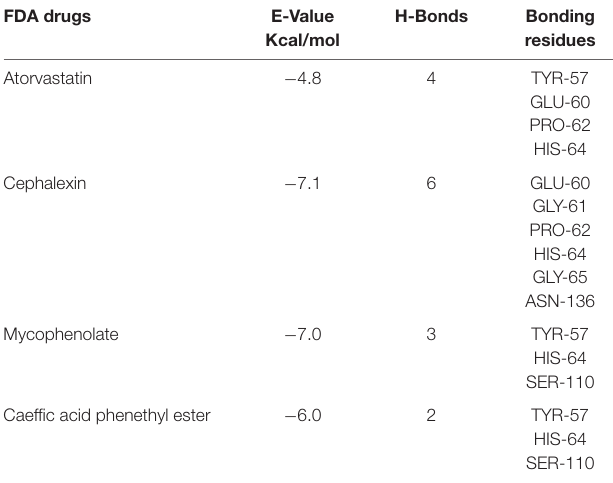
TABLE 2 | E-value (Kcal/mol) and post-docking analysis of best pose of atorvastatin, cephalexin, mycophenolate, and CAPE with NF- κ B. FDA